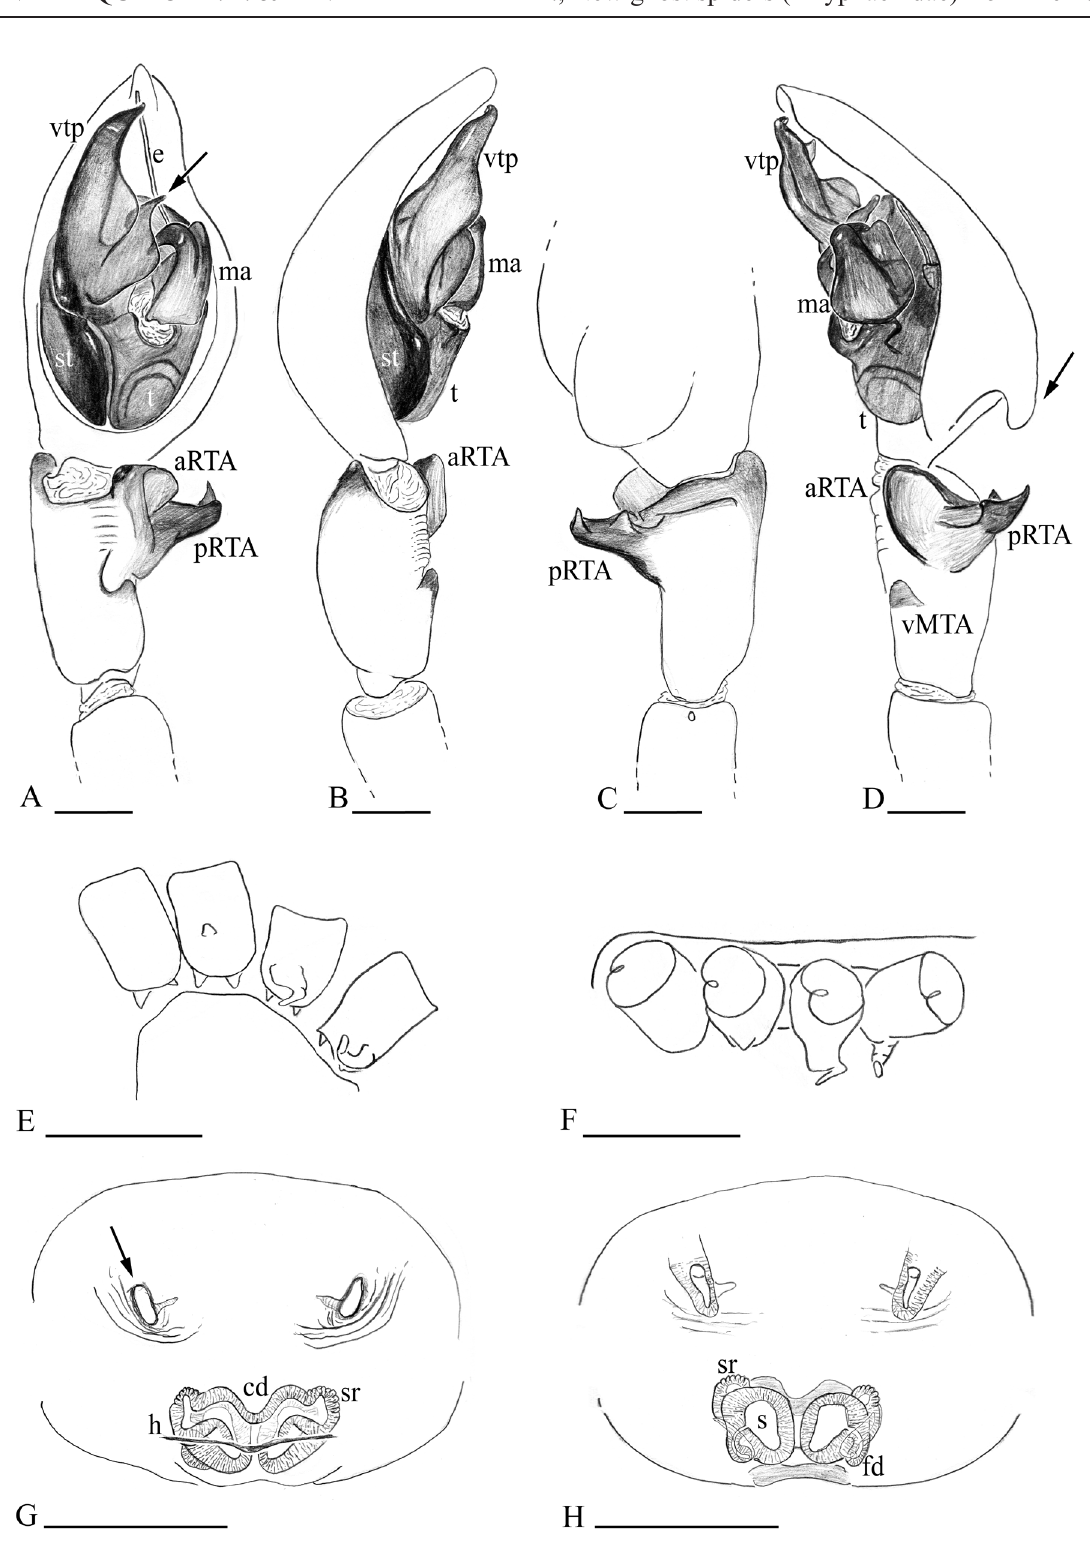
Fig. 15. Anyphaena urieli sp. nov. A–F . Paratype, ♂ (CNAN-T01582). G–H . Paratype, ♀ (CNAN-T01581). A . Pedipalp, ventral view. B . Pedipalp, prolateral view. C . Pedipalp, dorsal view. D . Pedipalp, retrolateral view. E . Coxae, ventral view. F . Coxae, lateral view. G . Epigynum, ventral view. H . Epigynum, dorsal view. Scale bars: A–D, G–H = 0.2 mm; E–F = 1.0